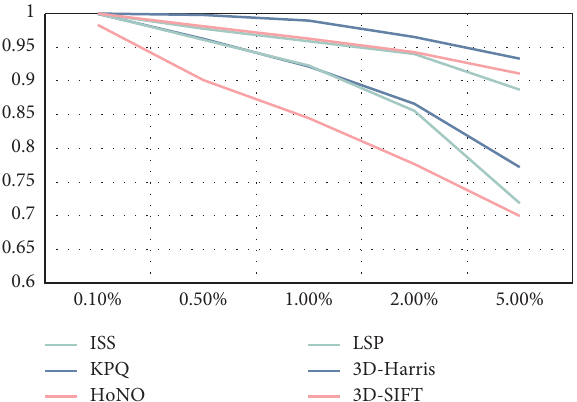
Figure 7: The relationship between the repetition rate and the proportion of